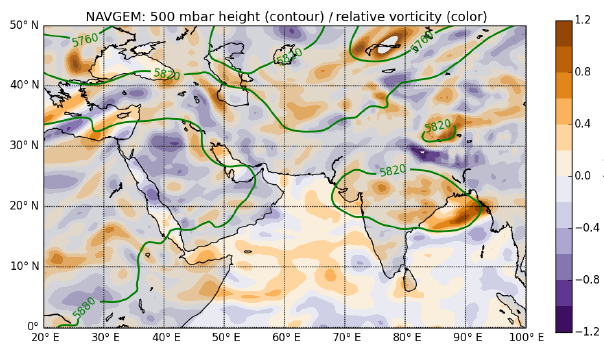
Figure 2. NAVGEM 500hPa geopotential height and relative vor- ticity analysis for 00:00Z, 3 August